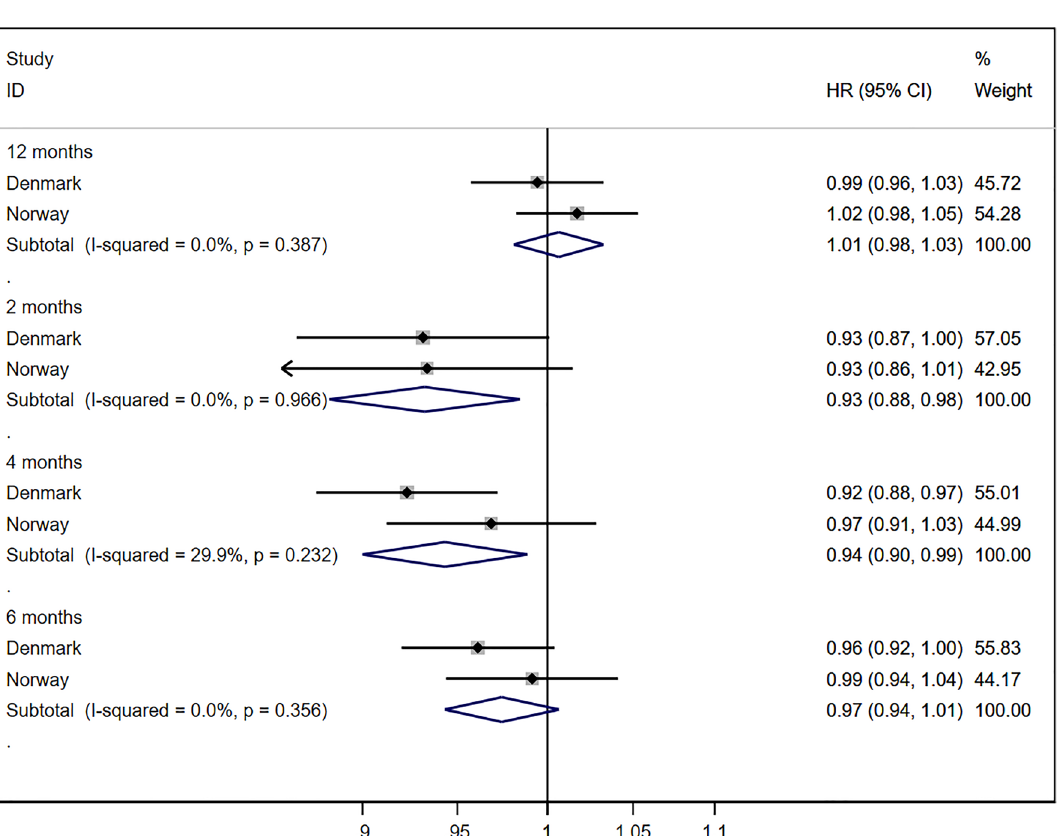
Figure 2. Estimates of the change in miscarriage in Denmark and Norway after March 12th, 2020. Sweden was not included in the analysis because the Swedish Pregnancy Register only includes deliveries after 22 completed gestational weeks. The hazard ratios are adjusted for calendar week at